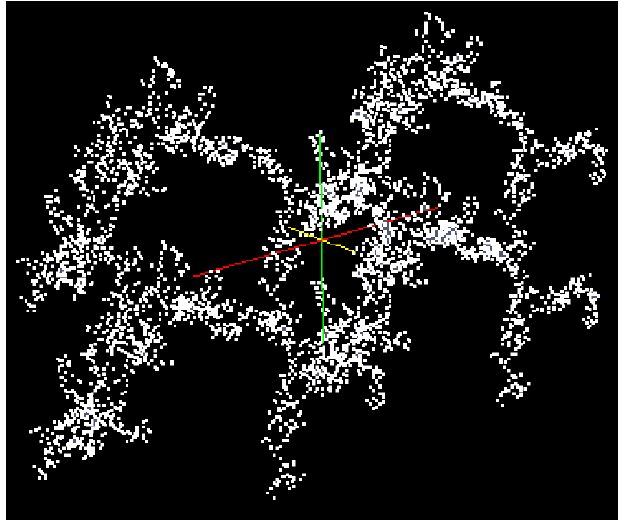
Figure 7. Arrangement of the clusters (2 × 2 clusters).